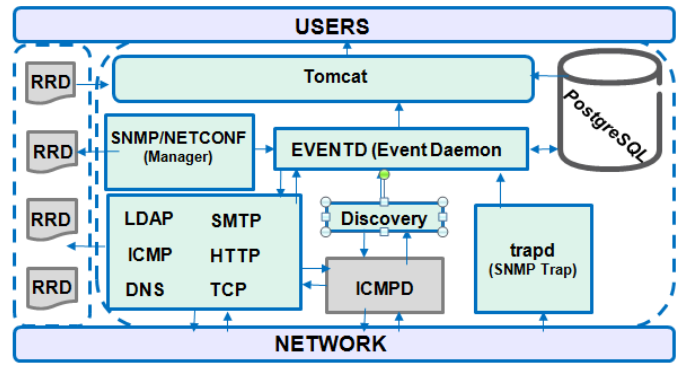
Figure 13. Illustration of the OpenNMS architecture.